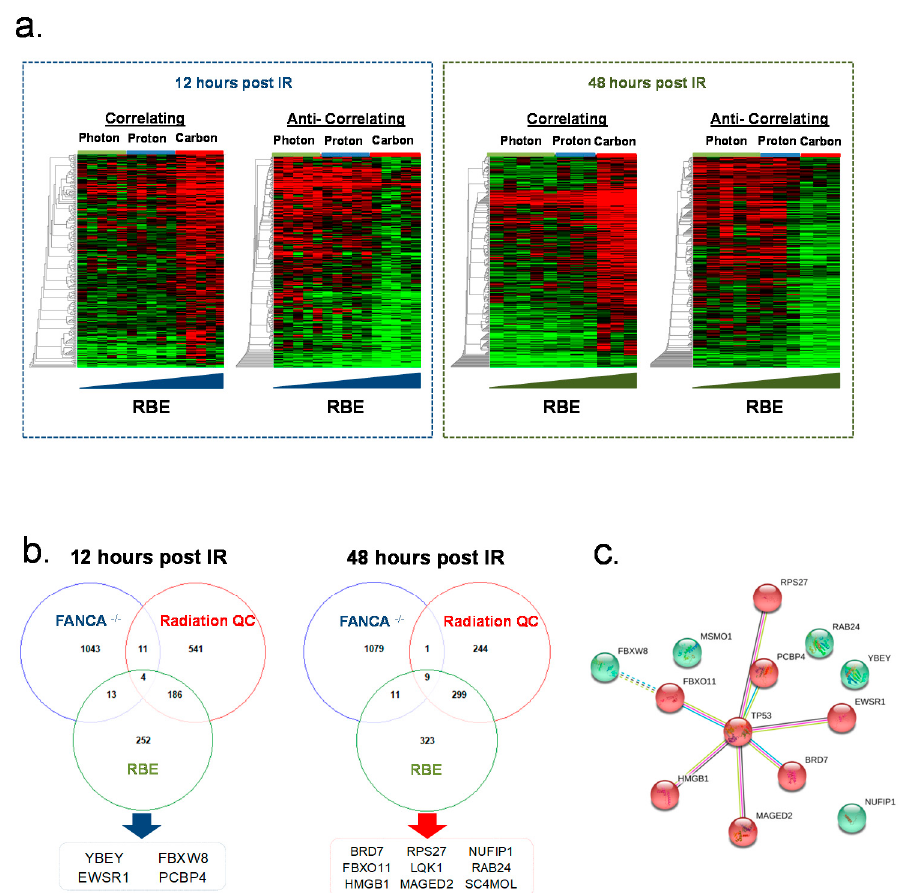
Figure 4. Gene expression changes as a function of Fanconi anemia, radiation quality and RBE. ( a ) gene expression heatmaps of genes which are correlated or anti-correlated with the higher RBE of carbon ions for the 12 and 48 h timepoint ( p < 0.05, PTM). ( b ) The Venn diagram represent the overlap of genes modulated by FA, radiation qualities (RQ), and relative biological effectiveness (RBE) status for each timepoint resembling the core set of genes modulating FA response to radiation. ( c ) Genes which were modulated as a function of FA, RQ and RBE were analyzed with the STRING Search Tool for the Retrieval of Interacting Genes/Proteins. Represented are genes which interact with each other over the TP53 access.